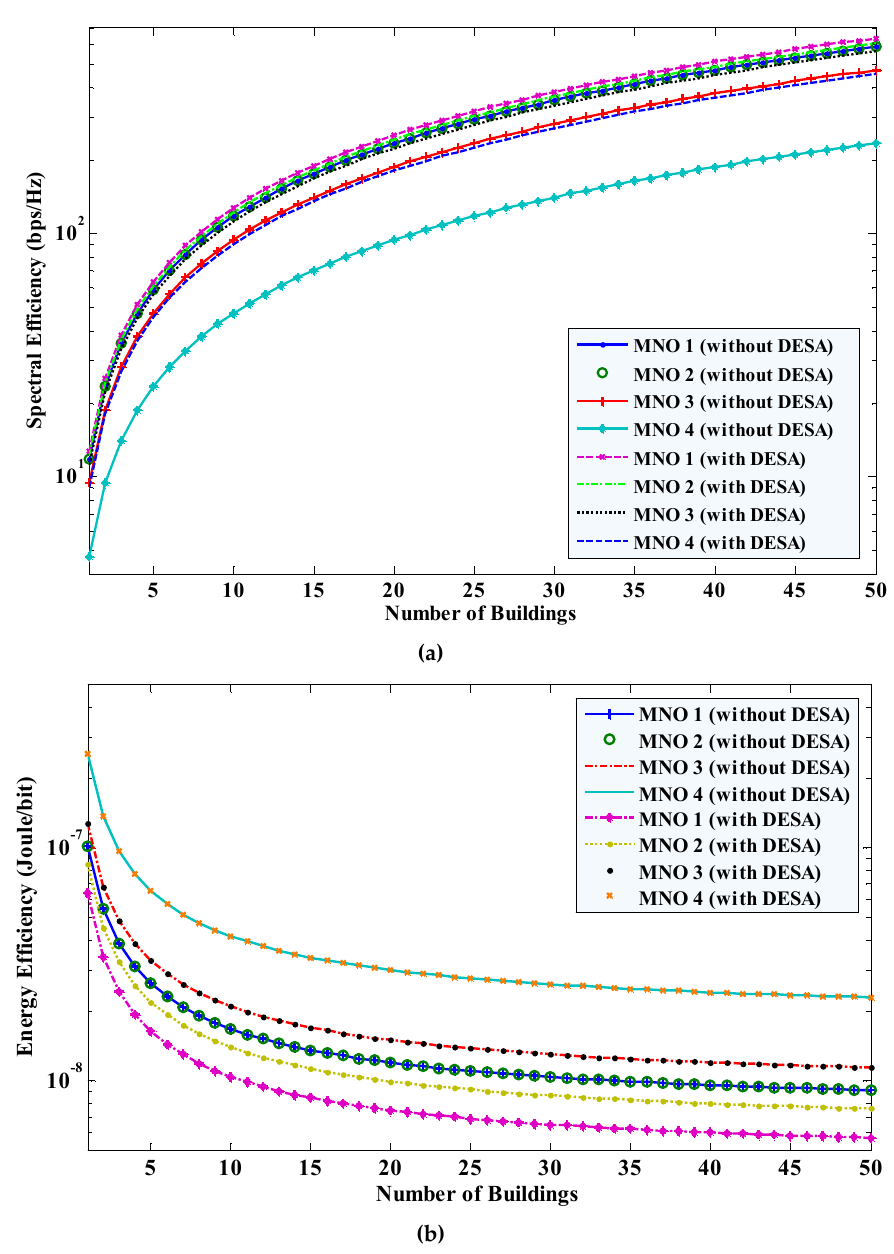
Figure 6. SE and EE performances of all MNOs with applying and without applying DESA for L >1: ( a ) SE; and ( b ) EE.